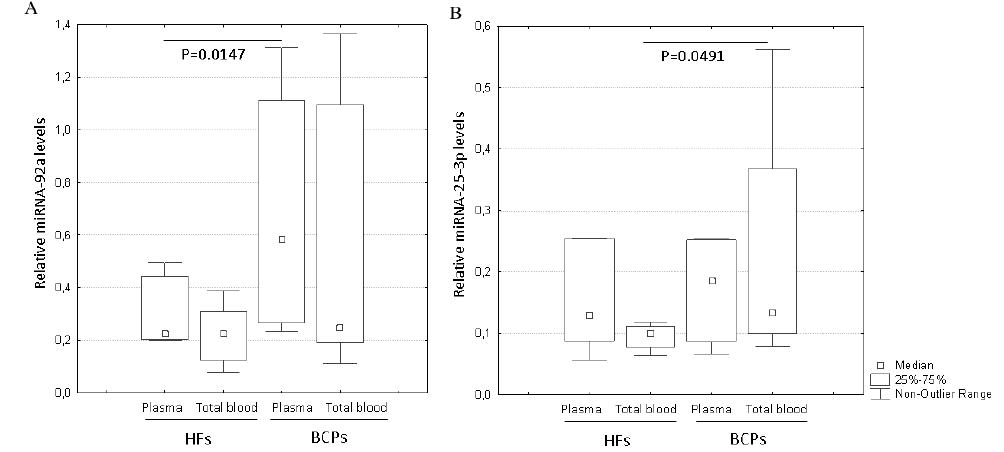
Figure 7. Quantification of exosomal miRNAs from the plasma and total blood of HFs and BCPs. Tukey box plots of miRNAs. The statistically significant p -values are indicated. miR-92a ( A ), miR-25-3p ( B ).